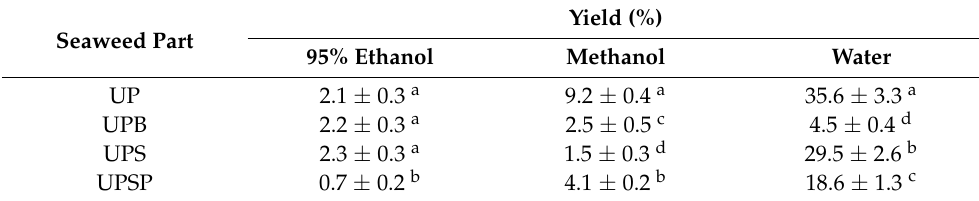
Table 1. Extraction yield of different parts of Undaria pinnatifida . Seaweed